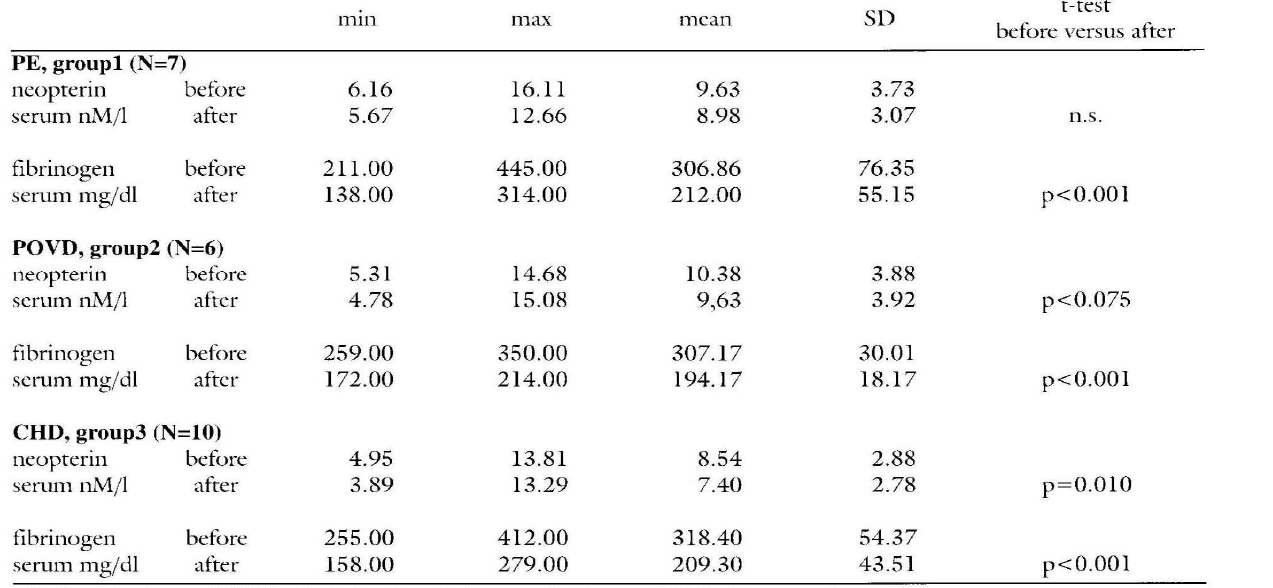
Table 2. Neopterin and fibrinogen before and after H.E.L.P. therapy in three patient